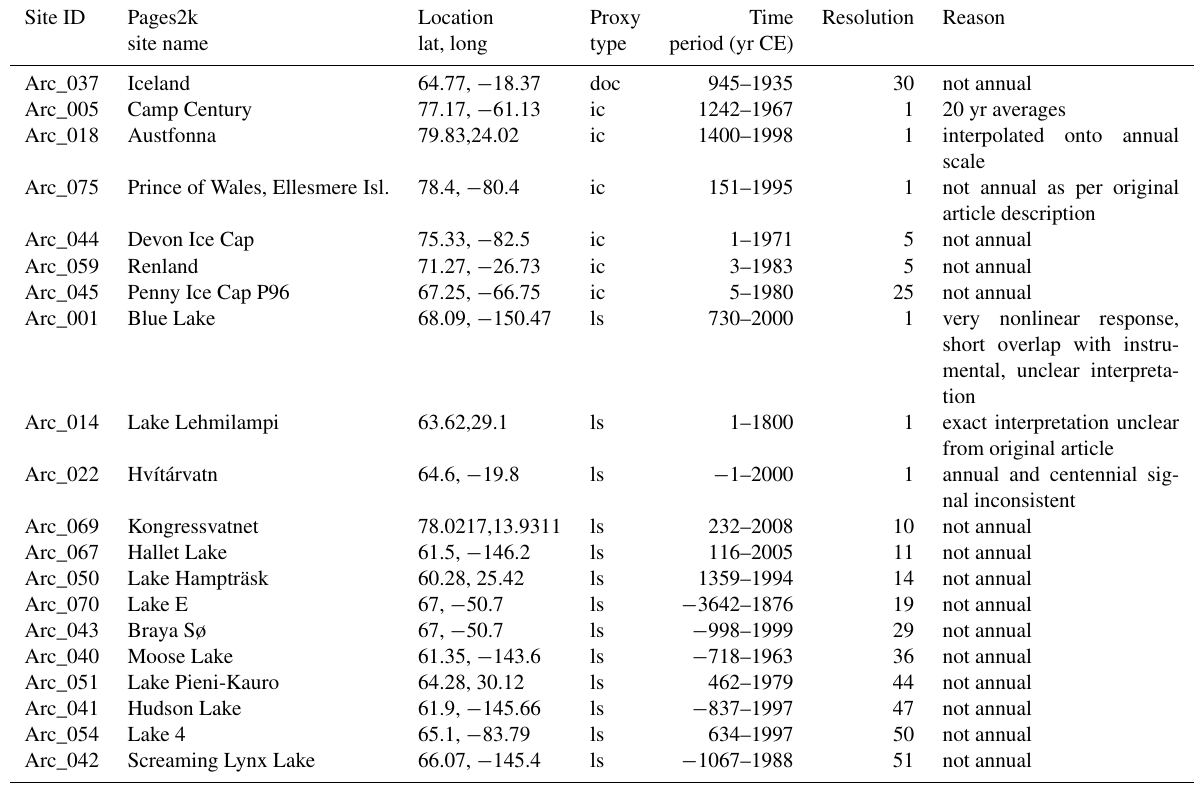
Table D3. List of the lake and ice core data from the PAGES2k database that were not used in this study.